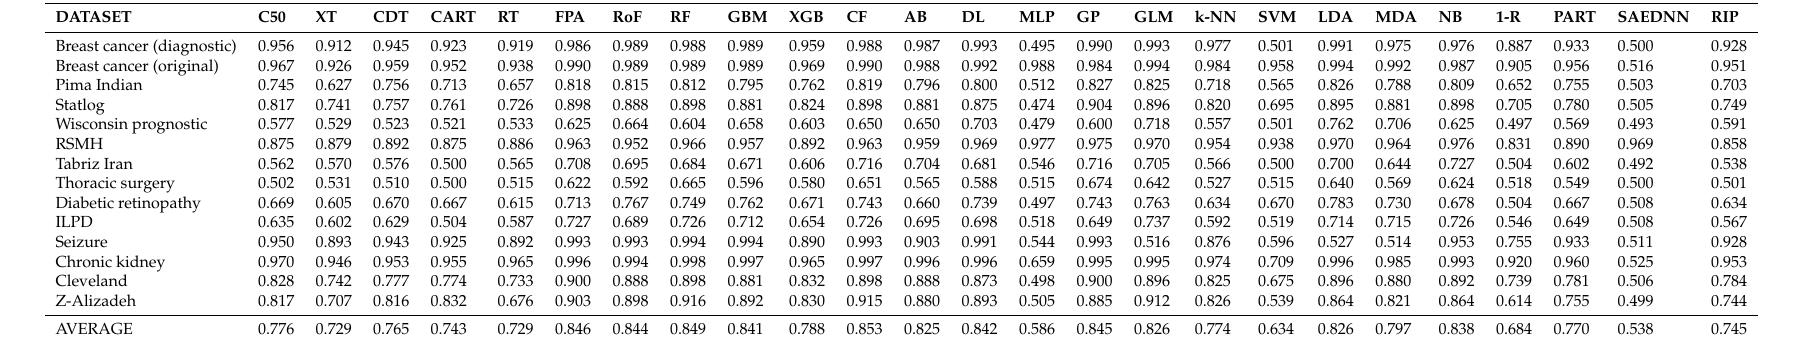
Table A3. Performance results of all classification algorithms w.r.t. 5